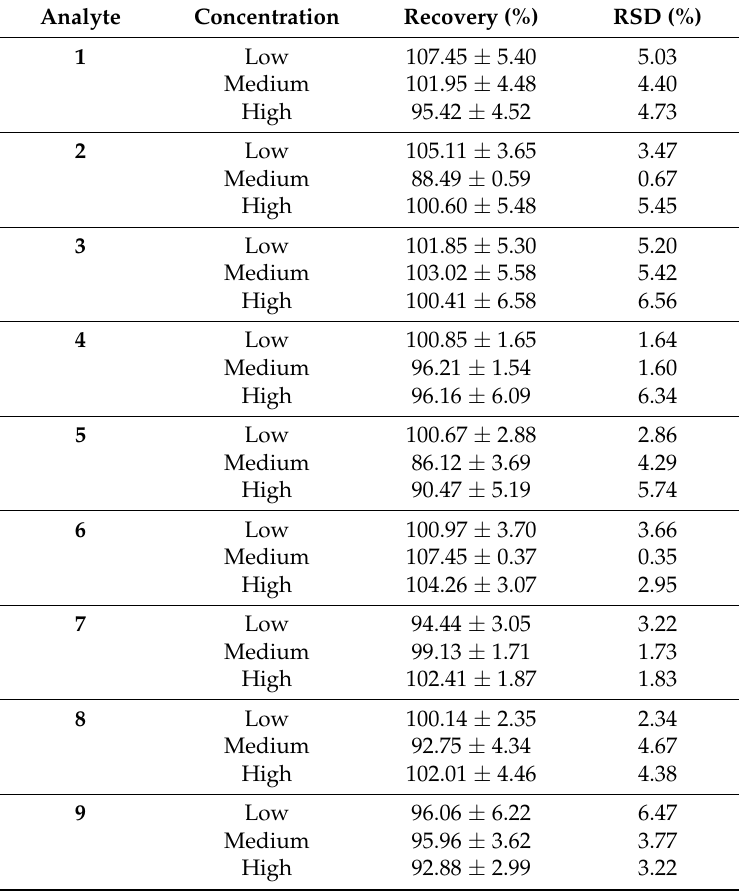
Table 4. Recoveries of the nine analytes by use of the high-performance liquid chromatography coupled with tandem mass spectrometry (LC-MS/MS) method ( n =